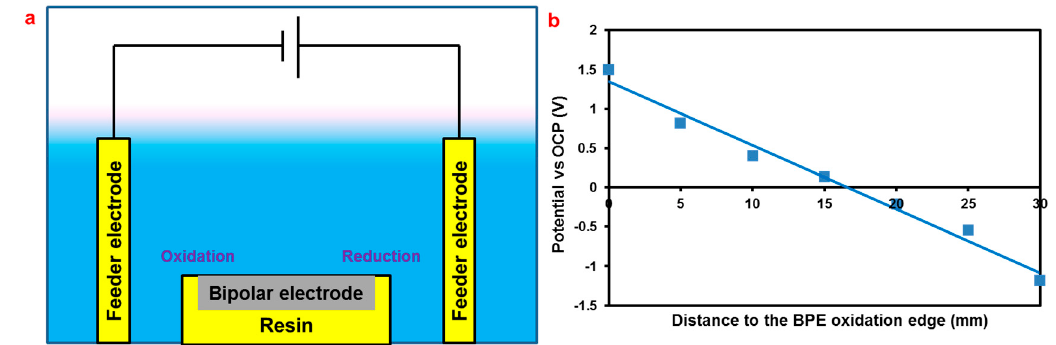
Figure 1. ( a ) A schematic diagram of the bipolar electrochemistry setup, and ( b ) the measured potential distribution on the bipolar electrode (BPE) (30 mm length) using a Luggin capillary connected to the saturated calomel electrode (SCE).